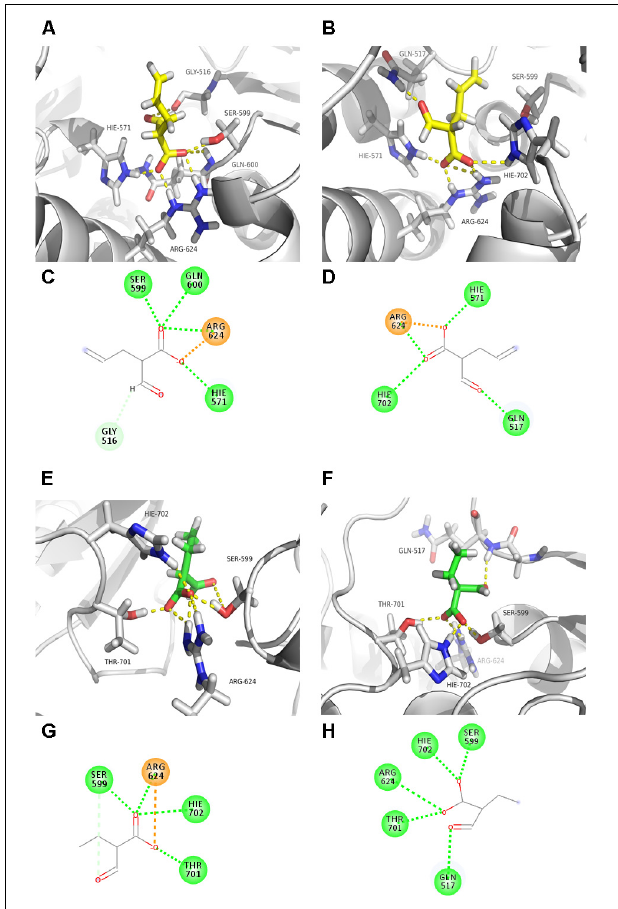
FIGURE 3 | Molecular interactions between the binding pocket of AT4 FkbB and its mutant Q119A-L185I-V186D-V187T-F203L with allmal or ethmal unit. Structure models of AT4 FkbB (A) or mutant (B) with bound allmal unit. Molecular interactions between residues in AT4 FkbB (C) or mutant (D) with the oxygen atoms of allmal group. Structure models of AT4 FkbB (E) or mutant (F) with bound ethmal unit. Molecular interactions between residues in AT4 FkbB (G) or mutant (H) with the oxygen atoms of ethmal group. Residues, allmal unit, ethmal unit, hydrogen and oxygen atoms were colored gray, yellow, green, dark blue, and red. The figures were made by PyMOL. The dotted green, orange, and soft blue lines between residues and the oxygen atoms of allmal- or ethmal group represented the conventional hydrogen bonds, the attractive charges and the carbon hydrogen bonds.